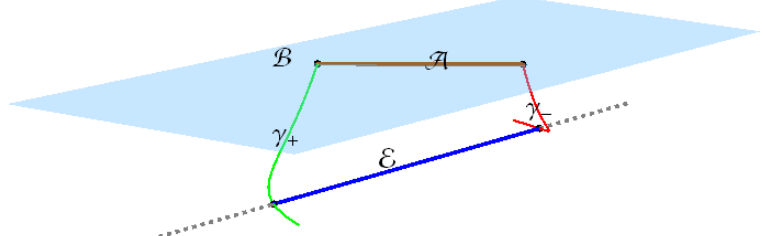
Figure 1 . The blue solid line is the E A which is regulated from the spacelike geodesic E . The red and green lines are the null geodesics (cid:13) (cid:6) that connect the endpoints of E A and A . with the results in [11, 12]. However, unlike the RT surfaces, the endpoints of E anchored on @ A